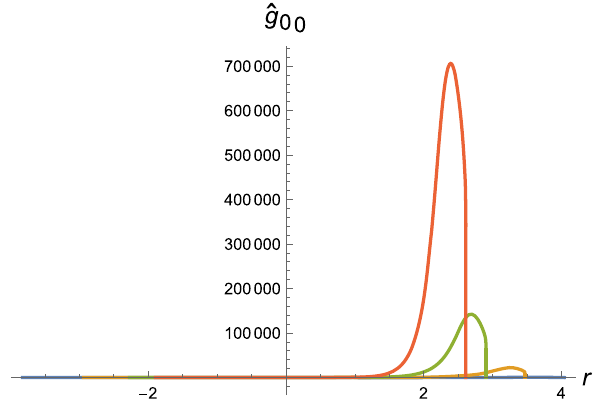
Fig. 6 Profiles of ˆ g 00 for RG flows between N = 1 SCFTs and N = 1 non-conformal field theories in four dimensions from SO ( 3 , 2 ) gauge